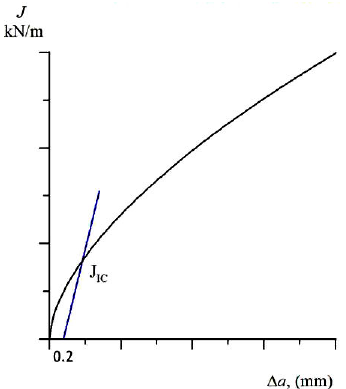
Figure 4. Example graph of J IC critical value.